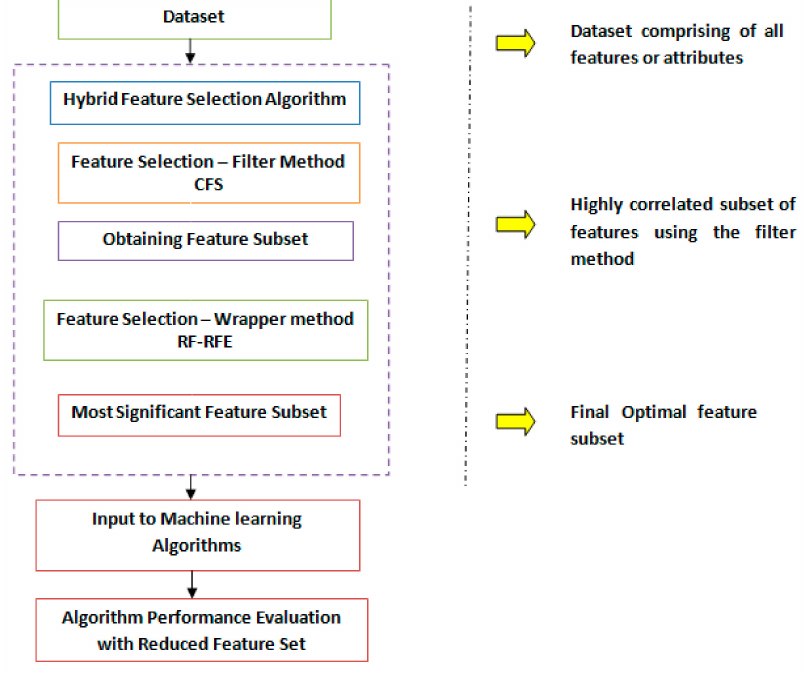
Figure 2. A framework of the proposed hybrid feature selection